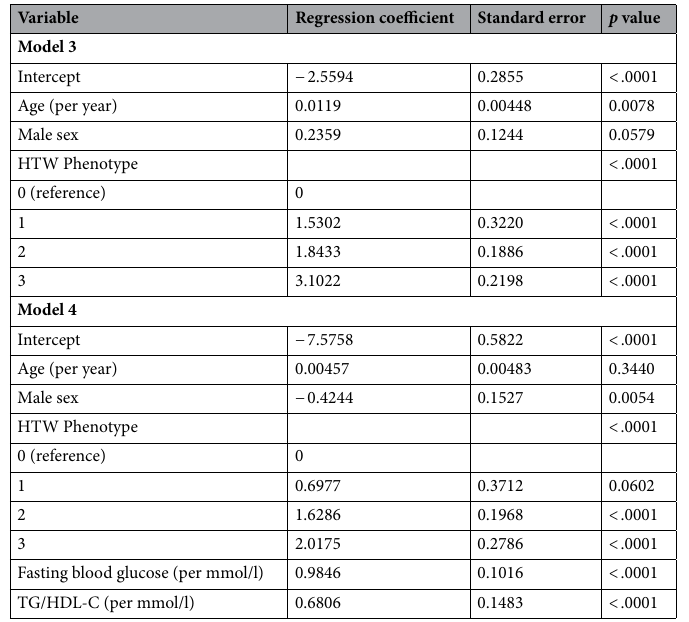
Table 7. Firth logistic regression models for the prediction of insulin resistance (Matsuda index < 4) using HTW phenotype.